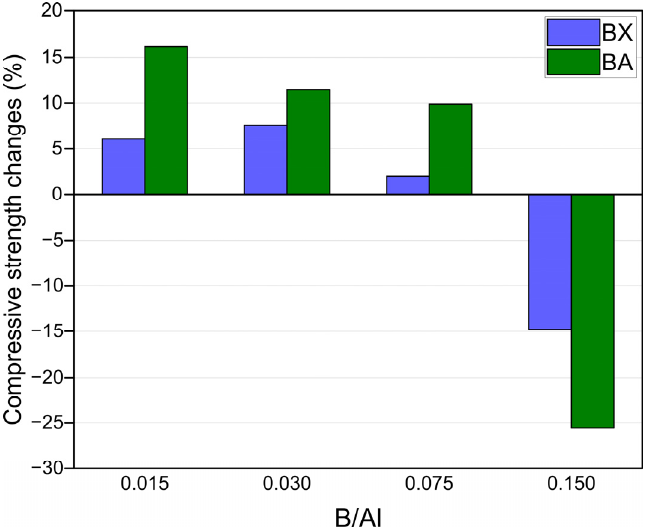
Figure 3. The relative changes in the compressive strength of geopolymers—the effect of the increasing boron content (in relation to geopolymer without boron).